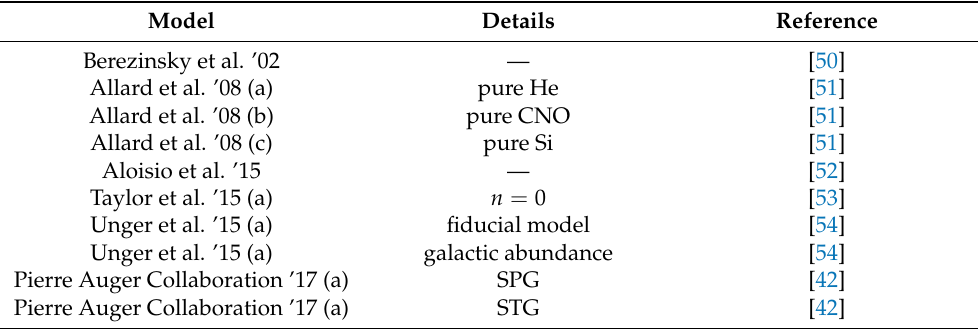
Table 1. List of UHECR models used. The middle column specifies the model when multiple ones come from the same